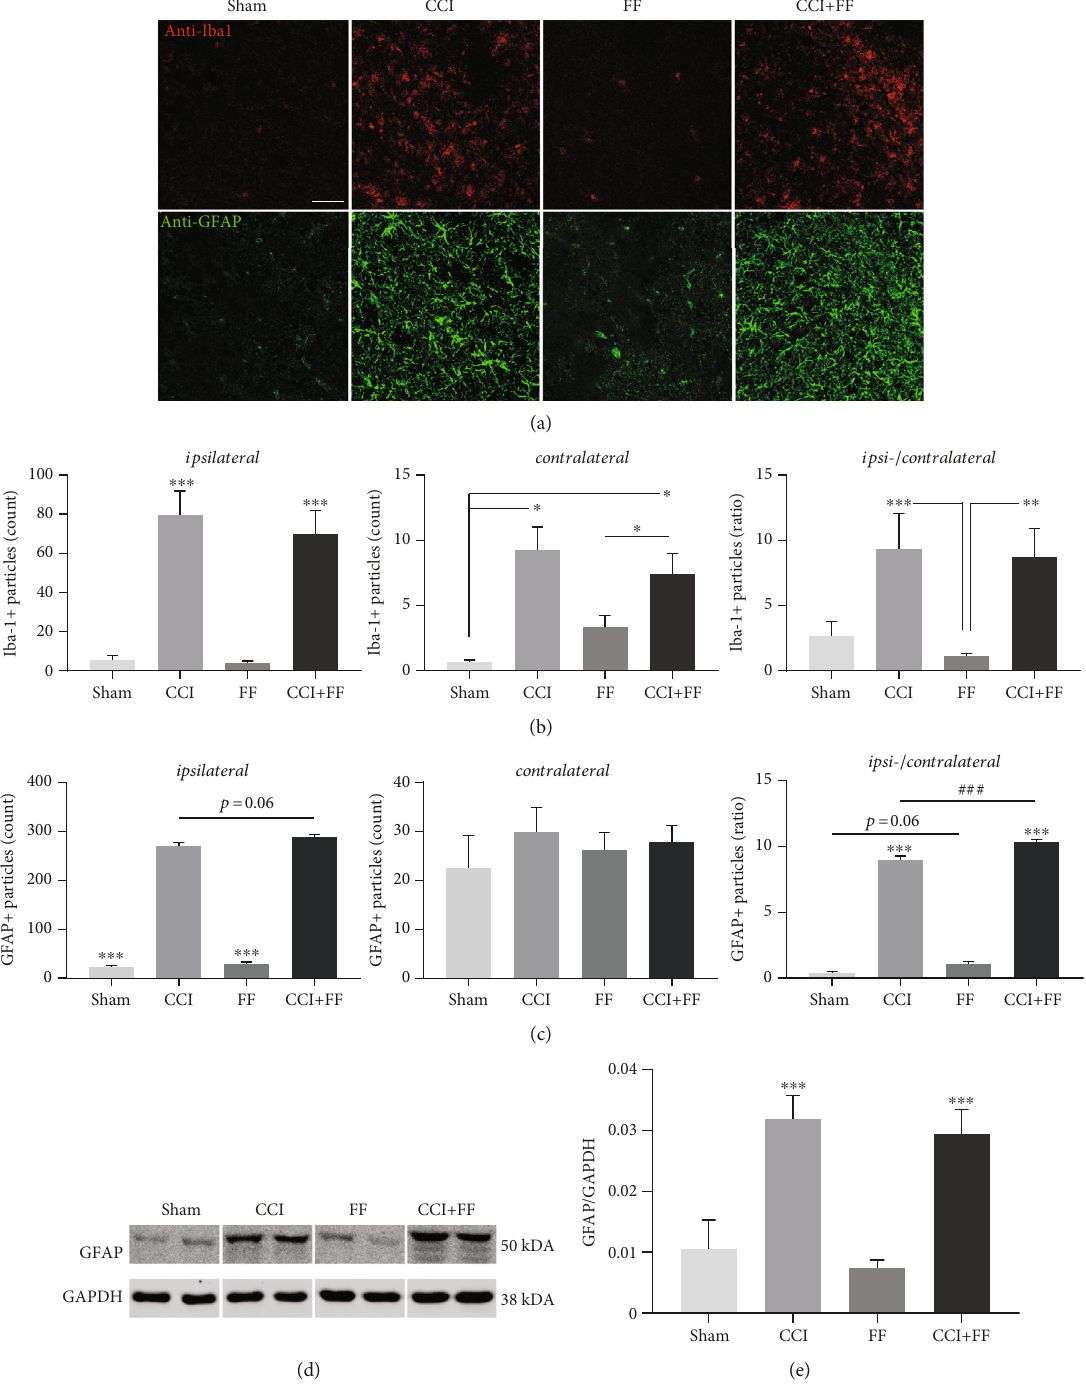
Figure 4: Astrogliosis is locally increased after TBI by concomitant femoral fracture. (a) Representative immuno fl uorescence images of brain sections at 5dpi showing microglia/macrophages (anti-Iba1, red) and reactive astrocytes (anti-GFAP, green) in the perilesional cortex of CCI and CCI+FF mice and corresponding regions of FF and sham mice (bregma -2.00mm, scale bar: 50 μ m). Quanti fi cation of (b) Iba-1 or (c) GFAP immunopositive particles in ipsi- and corresponding contralateral areas and the calculated ipsi-/contralateral ratios. The ipsi- /contralateral ratio of GFAP immunopositive particles was signi fi cantly increased in CCI+FF versus CCI ( ### , c). Isolated FF showed a statistical trend towards an increased ipsi-/contralateral ratio in comparison to sham ( p = 0 : 06 ). (d) Representative immunoblot demonstrating TBI-induced GFAP protein expression in the ipsilesional brain tissue at 5 dpi in CCI and CCI+FF mice. GAPDH served as reference protein. (e) Quanti fi cation of protein band intensities of GFAP normalized to GAPDH. Expression was increased in CCI and CCI+FF mice in comparison to sham and FF ( ∗∗∗ ) but not signi fi cantly altered in CCI versus CCI+FF groups. Values represent mean ± SEM ; p values were calculated by Holm-Sidak ’ s multiple comparison